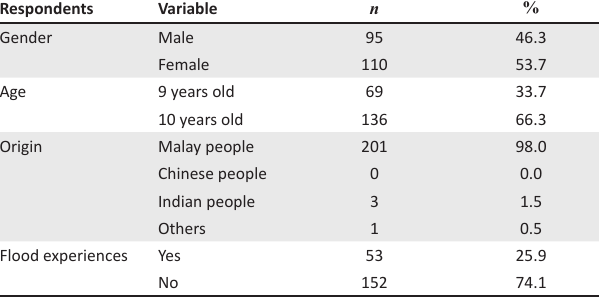
TABLE 2: The socio-demographic information of the school children ( N =